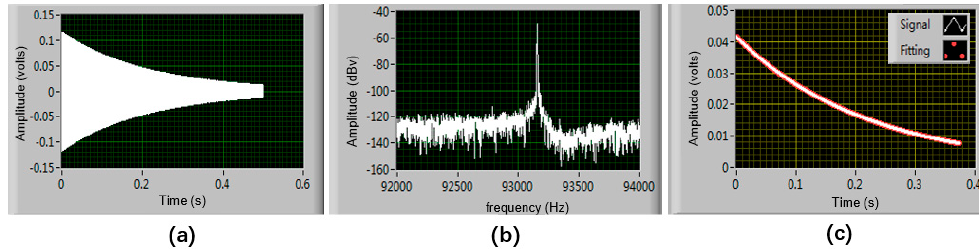
Figure 10. The frequency and quality factor of the DETF1 (Left) testing. ( a ) Ring-down waveform of the SRA vibration; ( b ) Resonant frequency test using FFT; ( c ) Envelope of the attenuation response curve.